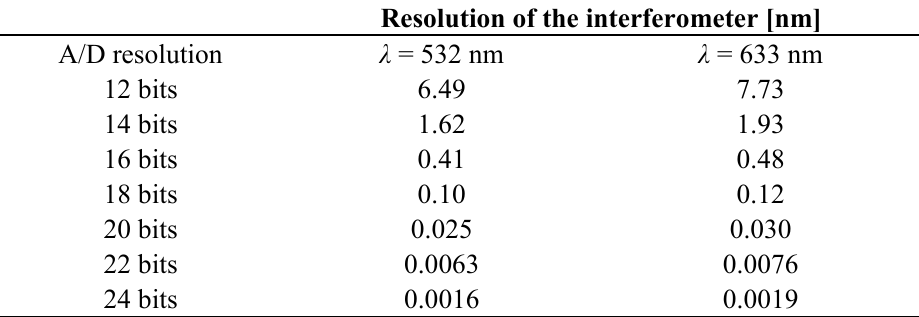
Table 1. Dependency between the resolution of A/D conversion and resolution (minimal detectable distance) of the interferometer for the 532 and 633 nm wavelengths